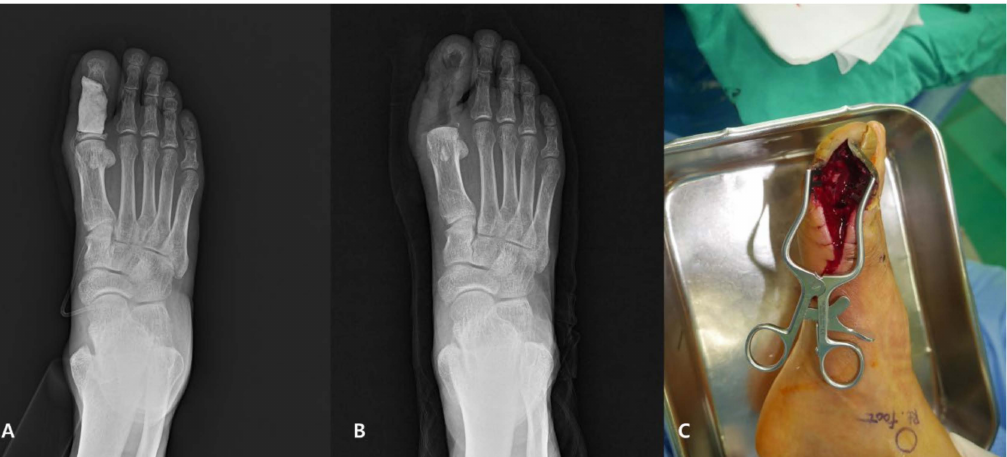
Figure 2. A 62-year-old male patient with diabetes who had had first phalanges infection and ACS insertion and received additional surgery due to uncontrolled infection. ( A ) The X-ray presentation of ACS insertion initially. ( B ) The radiograph after first ray amputation performed. ( C ) Pus filled with dead space after ACS was removed